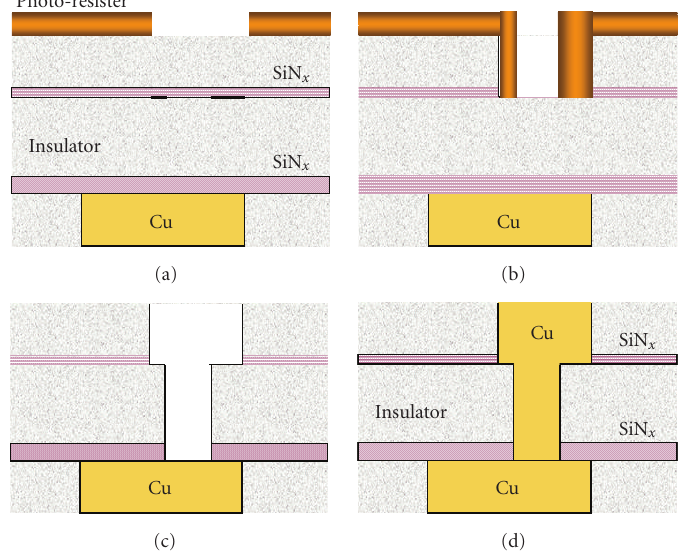
Figure 1: Schematic of typical dual damascene structure fabrication procedure: (a) stacked films with photo resister on top; (b) trench etching; (c) via etching; (d) Cu filling and polish process.